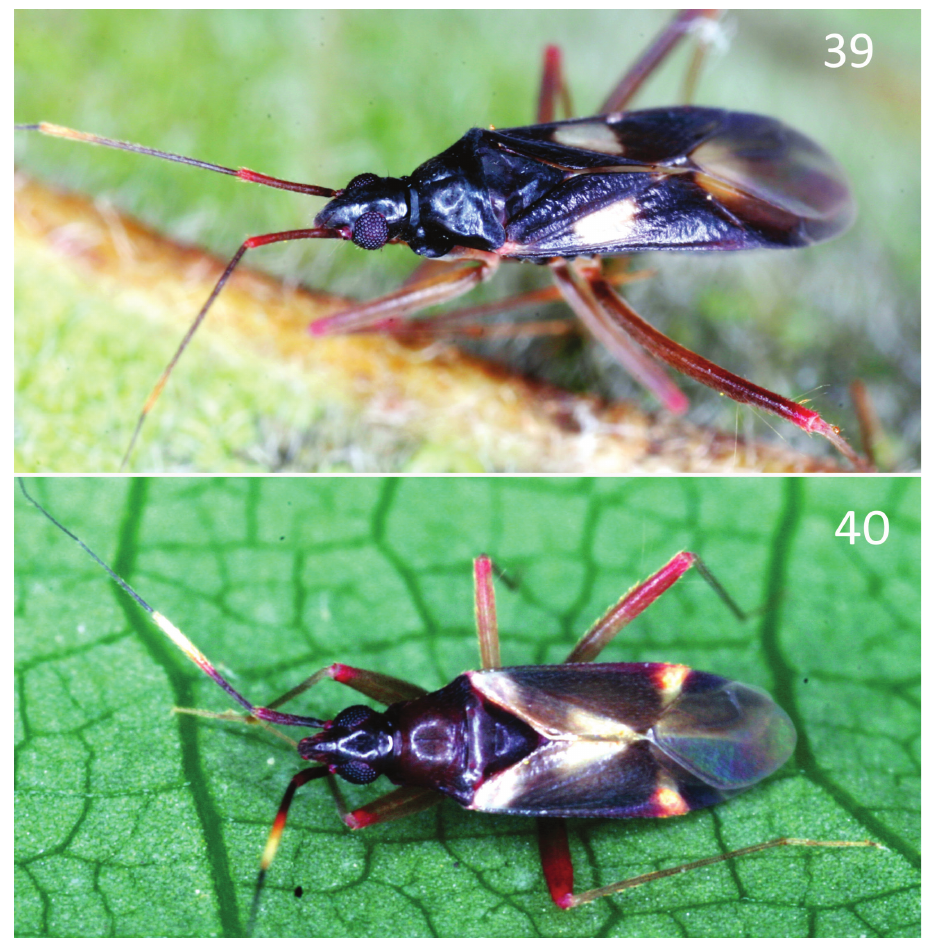
Figures 39–40. Live female adults of Fulvius bifenestratus ( 39 ) and F. subnitens ( 40 ) captured using UV light trap at Sakaerat Environmental Research Station, Thailand. margin of each eye; eyes slightly removed from pronotal collar; antennae covered with dense, semidecumbent setae; rostrum distinctly surpassing half of abdominal length, sometimes reaching apex. Abdomen . Apical portion of abdomen flattened ventrally. Male genitalia (Figs 25, 26). Left paramere (Figure 25). Apical process and paramere body forming obtuse angle; paramere body relatively thick, left margin convex in sin- istrolateral view, arcuate, right margin weakly sinuate, concave; apical process when viewed sinistrolaterally with basal two thirds cylindrical and apical third weakly taper- ing toward apex, ventral margin with distinct subapical spine. Aedeagus (Figure 26). Endosoma tumid, membranous, divided into two, large lobes apically, sclerotized por- tion of ductus seminis inside endosoma relatively long, tapering toward apex. Female . Similar to male in coloration, structure, texture, and